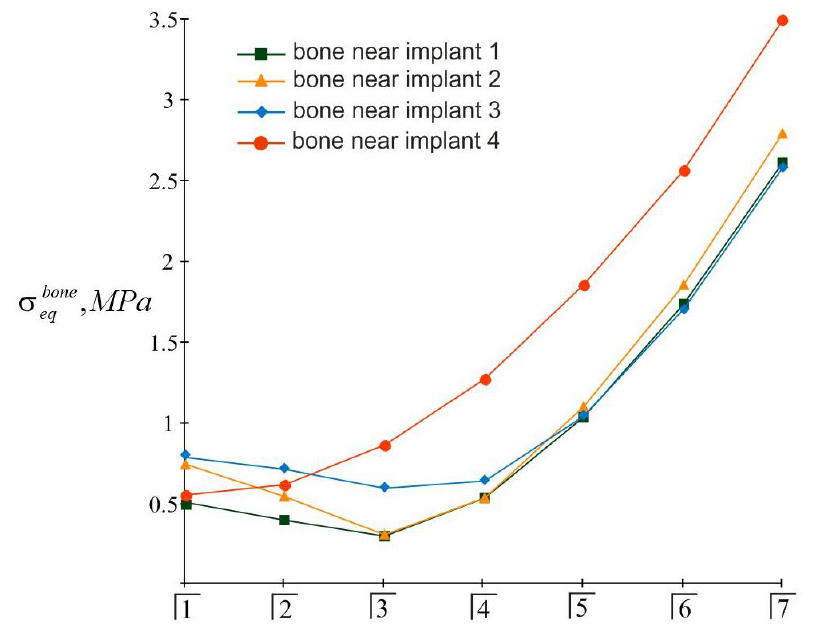
Figure 16. Comparative analysis of maximum equivalent stresses in bone tissue at different locali- zations of the mastication load (the second variant of implant placement).